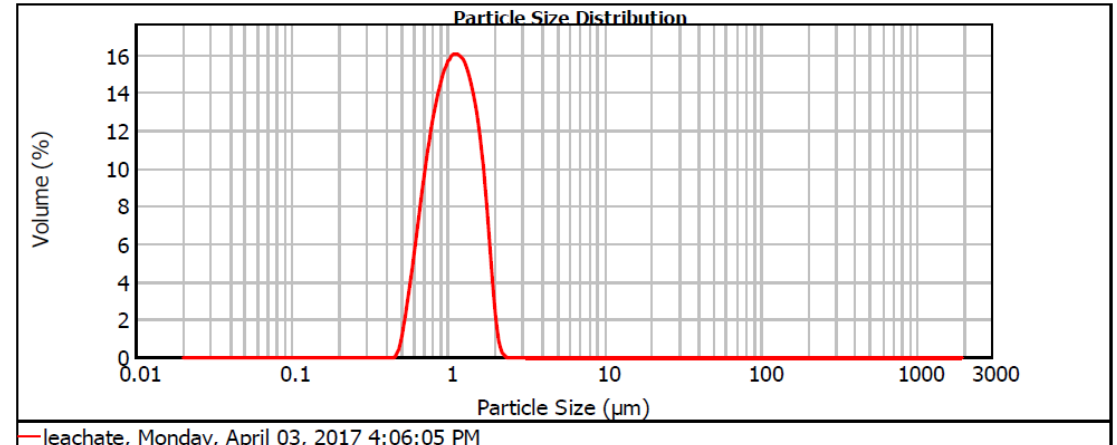
Figure 1. Particle size distribution for (a) landfill leachate.